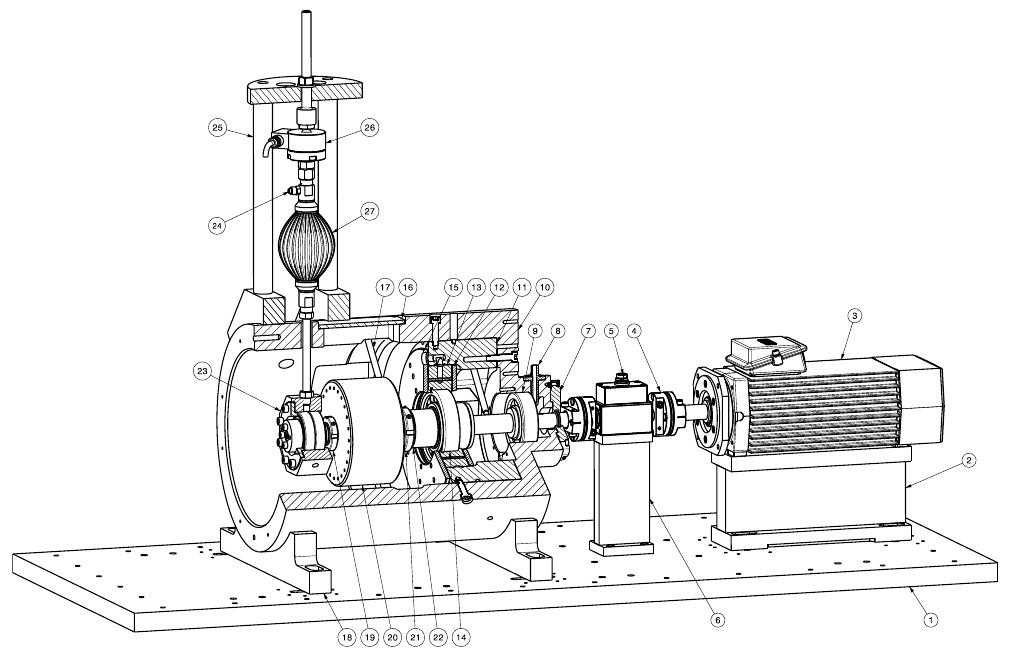
Figure 8. Technical drawing of the novel rotor dynamic test